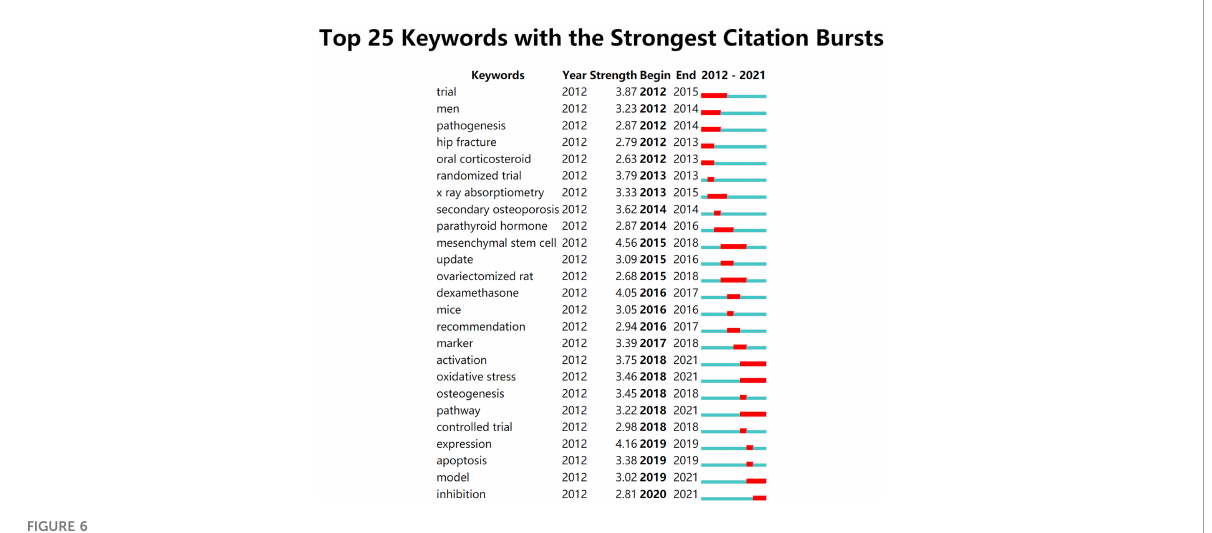
FIGURE 6 Top 25 keywords with the strongest citation